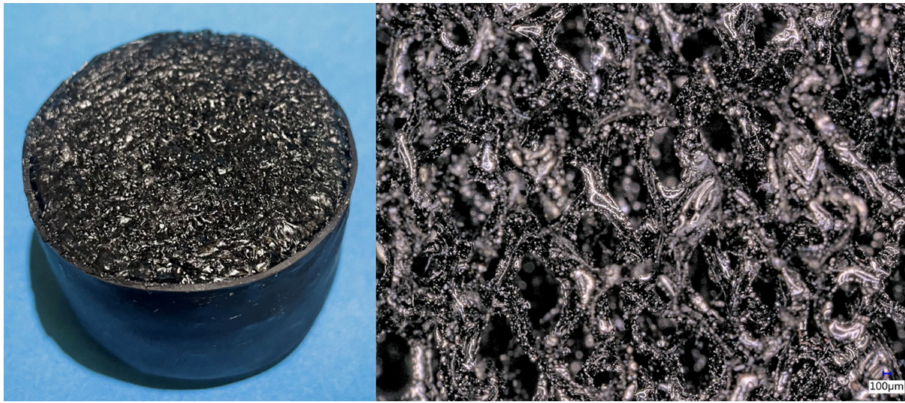
Figure 4. ( Left ) Fat filled carbon specimen with shrink tube, ( right ) close up of Carbon